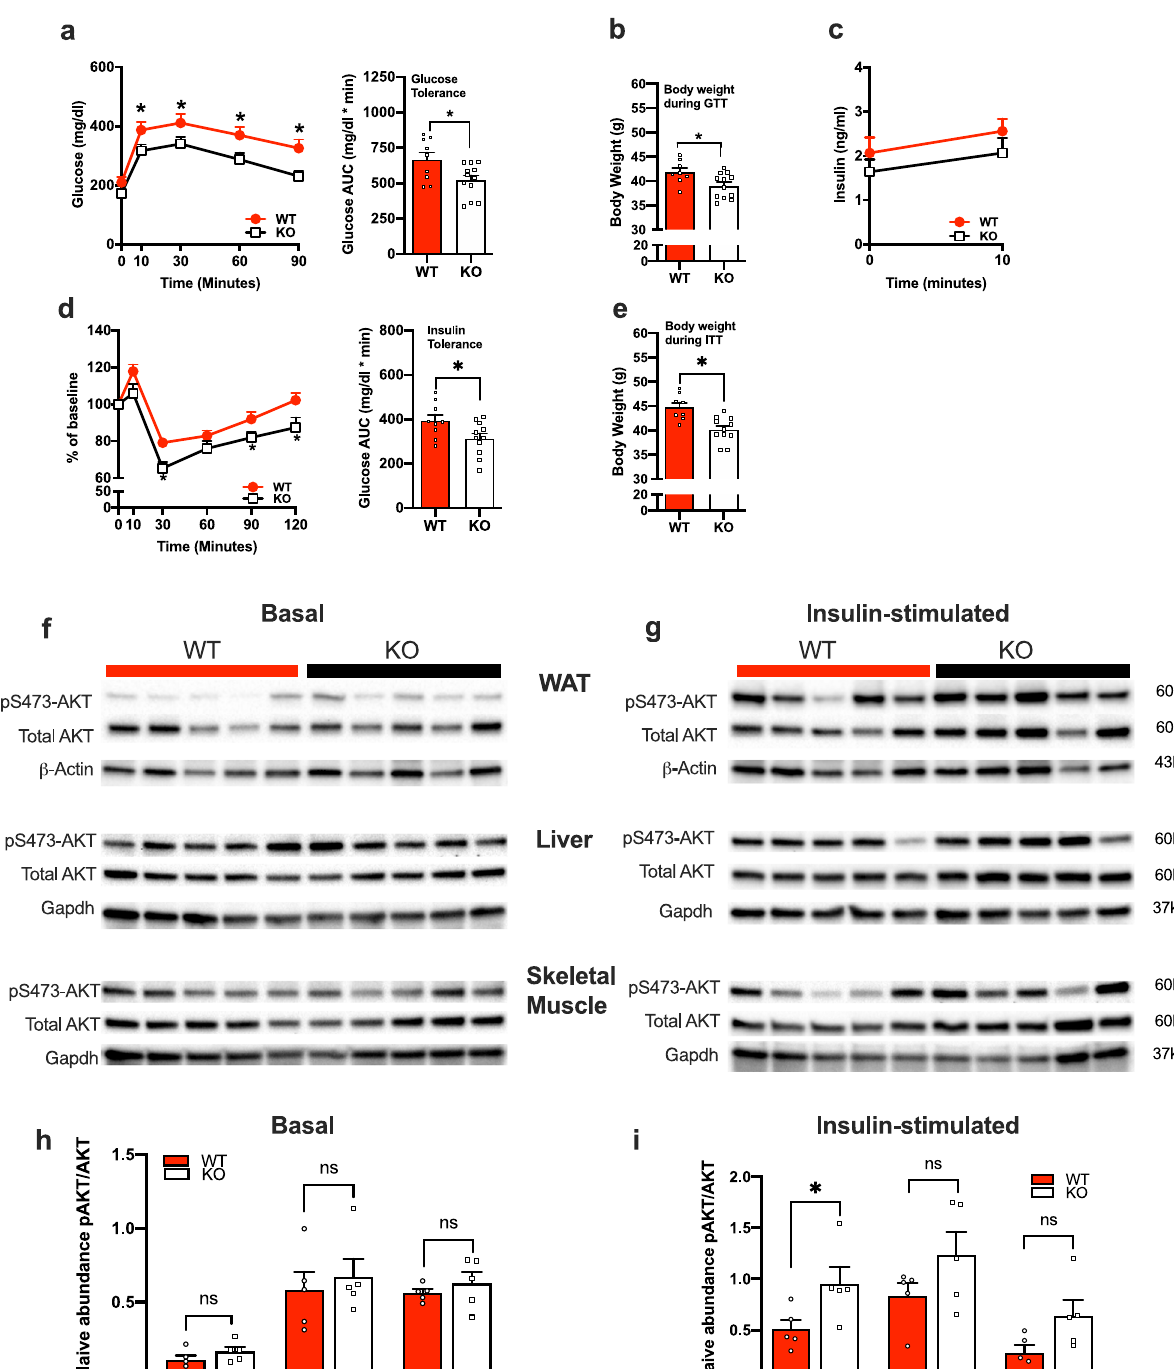
Fig. 5 | ATP6v0a1 depletion in adipocytes results in improved glucose home- ostasis. a Glucose tolerance test (GTT; genotype: F =6.15, df=1, p =0.02; time: F =63.69, df=4, p <0.001; genotype X time: F =1.40, df=4, p =0.24). b Body weight at time of GTT ( t =2.52, df=19, p =0.01). c Glucose-stimulated plasma insulin(genotype: F =1.14,df=1, p =0.30;time: F =11.37,df=1, p =0.003;genotype Xtime: F =0.06,df=1, p =0.80). d Insulintolerancetest(ITT),presentedaschange from baseline (genotype: F =6.76, df=1, p =0.01; time: F =59.95, df=5, p <0.001; genotype X time: F =2.18, df=5, p =0.06). e Body weight at time of ITT, ( n =9-12/ group; t =3.78, df=17, p <0.001). Immunoblots of total AKT and phosphorylated AKT at Ser473 in WAT, liver and skeletal muscle in f the basal state g